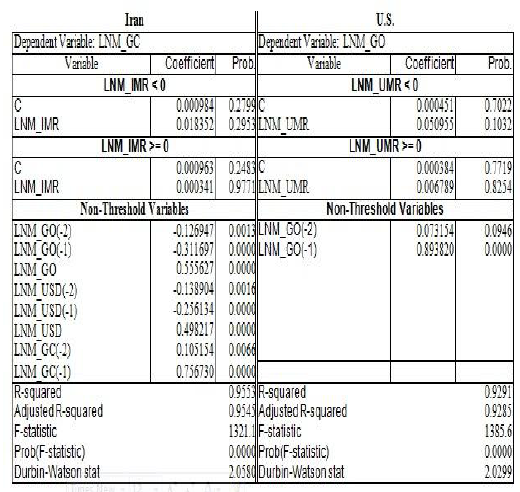
Table 9: Serial Correlation Test of Monthly Returns